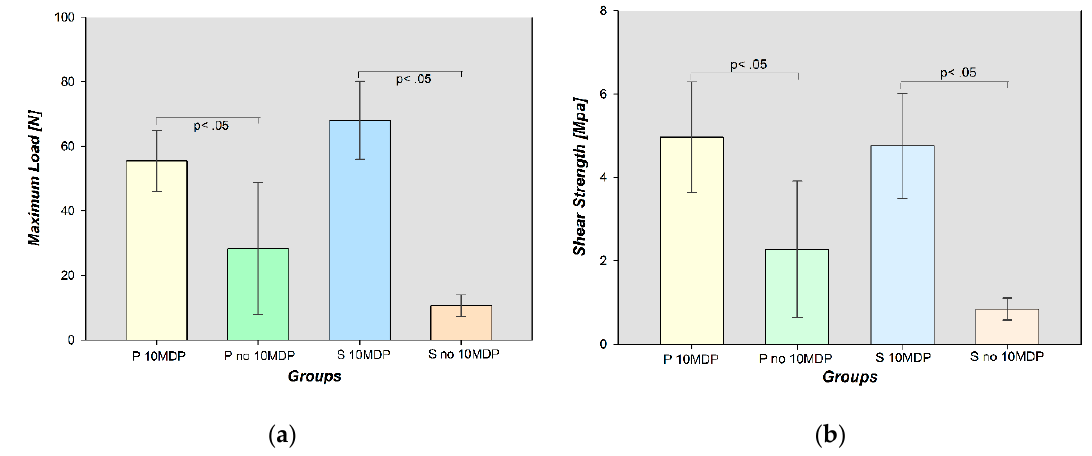
Figure 4. Graphical representation of mean values ( ± SD) of maximum load and shear bond strength.